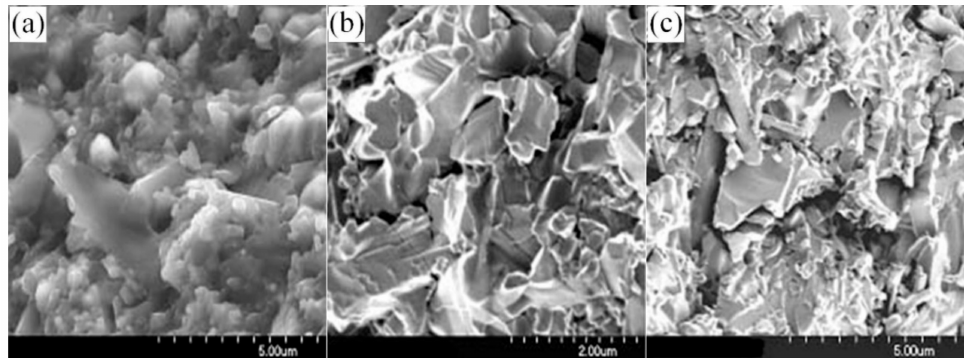
Figure 9. SEM microstructure of the fracture surfaces of the Si 3 N 4 –MoSi 2 composite samples. ( a ) Before thermal shock, ( b ) thermal shock at 500 ◦ C, and ( c ) thermal shock at 600 ◦